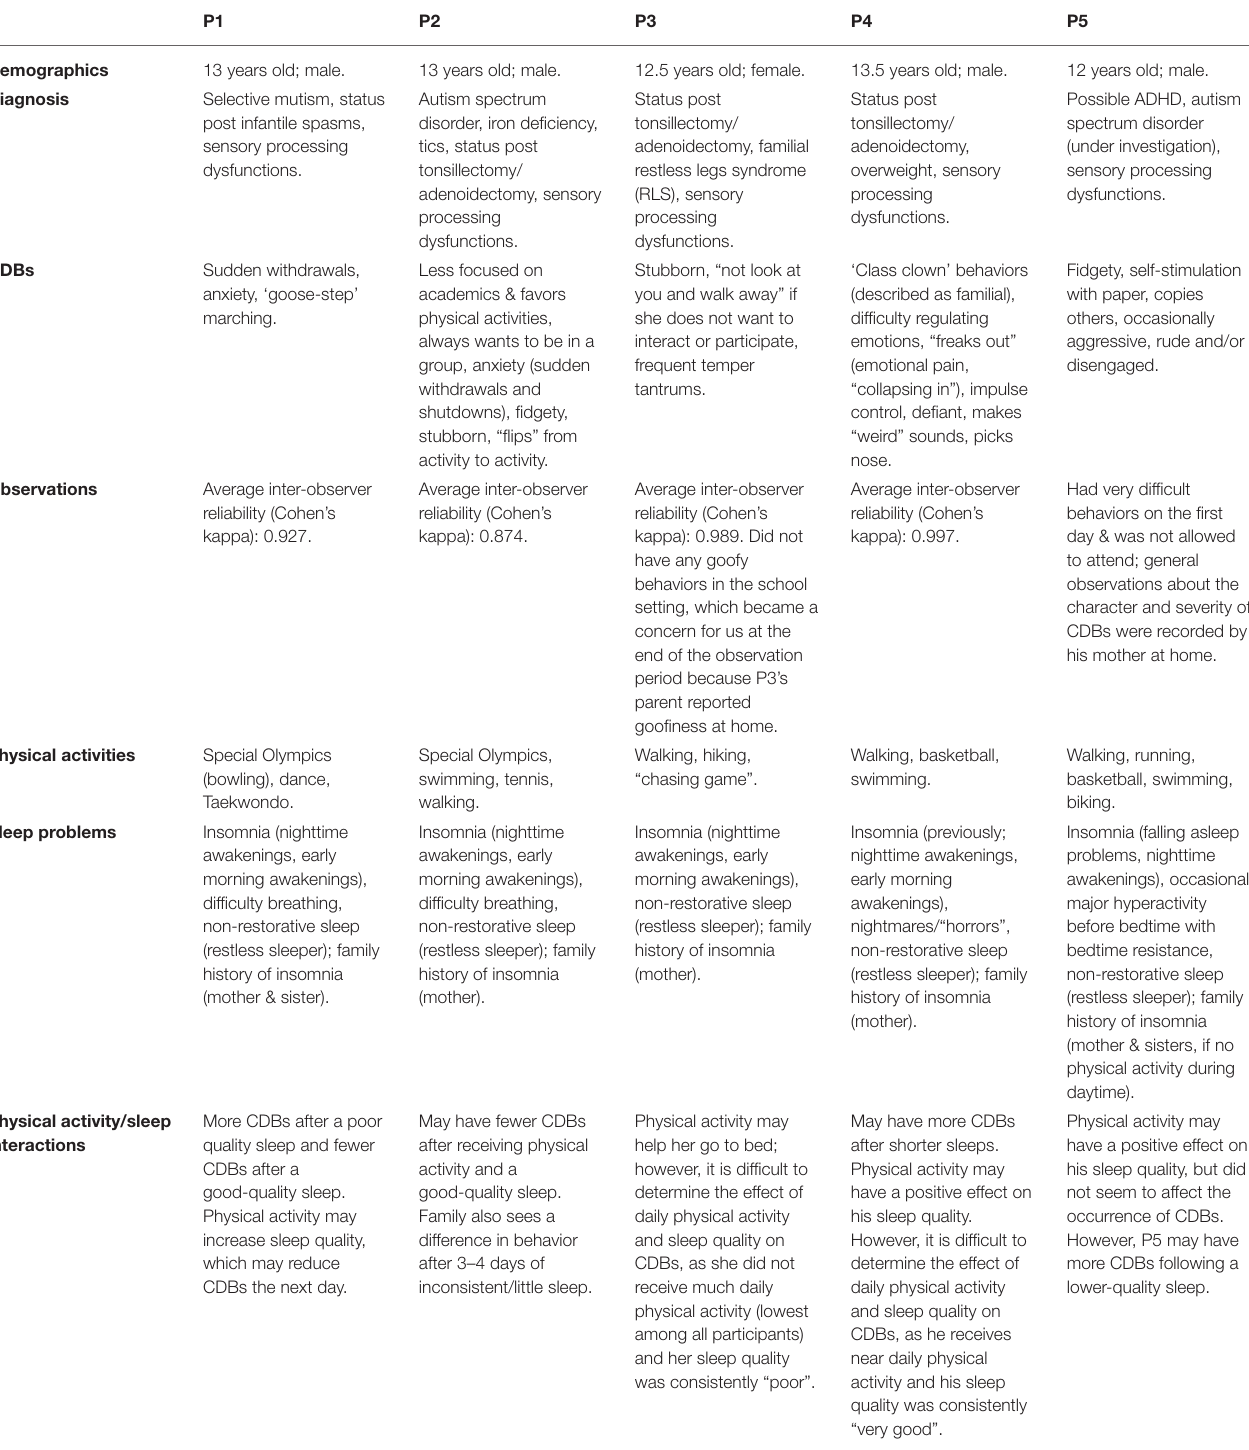
TABLE 2 | Participant